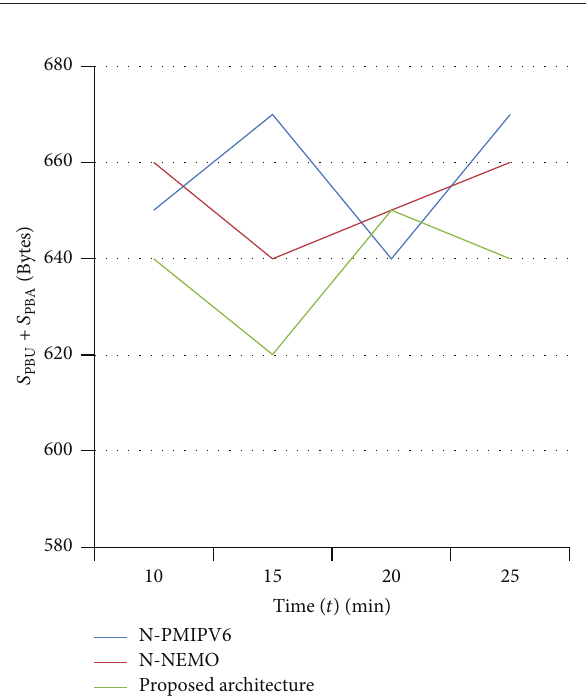
Figure 12: Analysis on signaling cost by introducing random mobility to the mobile